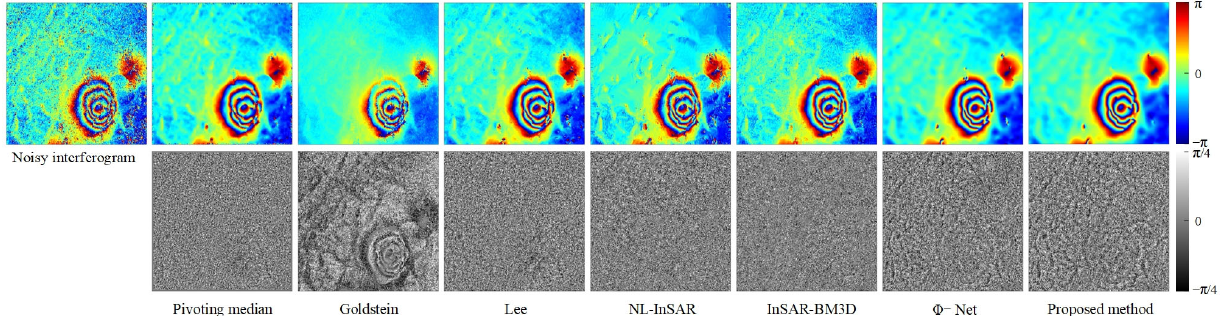
Figure 6. The noisy interferogram filtering results for the Jinchuan mine. The first row shows the filtered interferogram. The second row shows the noise image; the visibility of the phase fringe traces in the noise image indicates the phase filtering method’s ability to preserve detail.